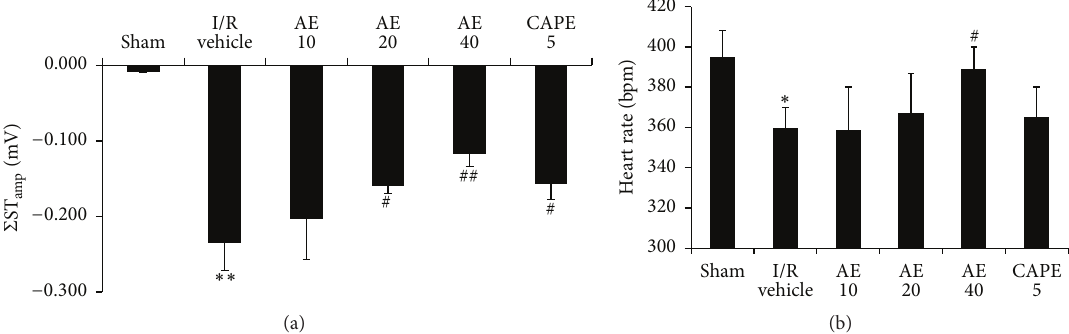
Figure 3: Effects of AE on ST-depression and heart rate of ECG after I/R in rats. (a) ST amplitude changes ( Σ ST amp ). (b) The lead II ECG was recorded continuously for 15 min at 24 hours after I/R. Different doses of AE (10, 20, or 40 mg/kg), CAPE 5 mg/kg, or saline (1mL/kg) were administered via the tail vein 1min before reperfusion. 𝑛 = 10 /group. ∗ 𝑃 < 0.05 , ∗∗ 𝑃 < 0.01 , versus Sham; # 𝑃 < 0.05 , ## 𝑃 < 0.01 versus I/R